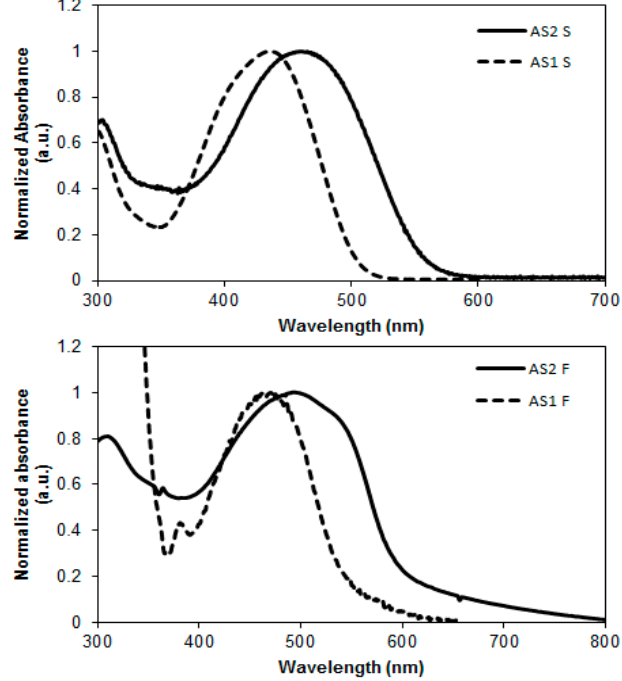
Figure 4. Normalized absorption spectra of compounds AS2 and AS1 in CHCl 3 solutions ( upper ) and for pristine as-casted films ( lower ); (films of AS2 and AS1 were spin-coated at 2000 rpm for 1 min to give a film thickness of ~70 nm).